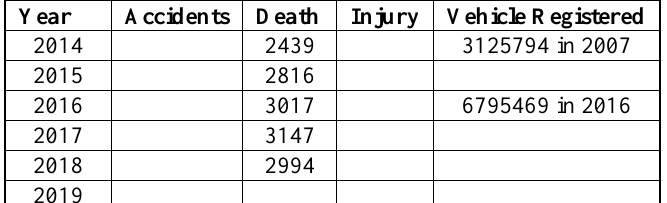
Table 19: Time series data on road accidents.